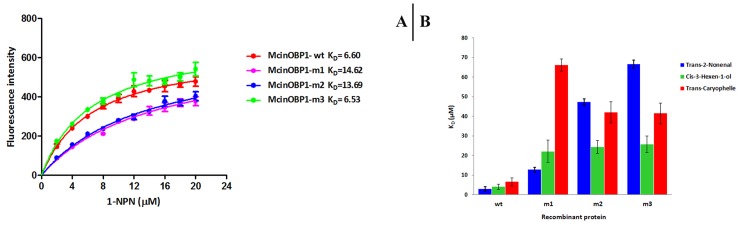
Binding of 1-NPN and ligands to McinOBP1 mutants.(A) Affinities of 1-NPN to the McinOBP1-wt and three mutants. Dissociation constants (KD) were 6.60 μM for McinOBP1-wt, 14.62 μM for McinOBP1-m1, 13.69 μM for McinOBP1-m2 and 6.53 μM for McinOBP1-m3 are shown in inset. (B) Dissociation constants of complexes between McinOBP1-wt and its three mutants (McinOBP1-m1to 3) and the three selected odorants. These three mutants showed lower binding affinity to selected three odorants with respect to the wild type, indicating that the respective amino acids are involved in binding these ligands.